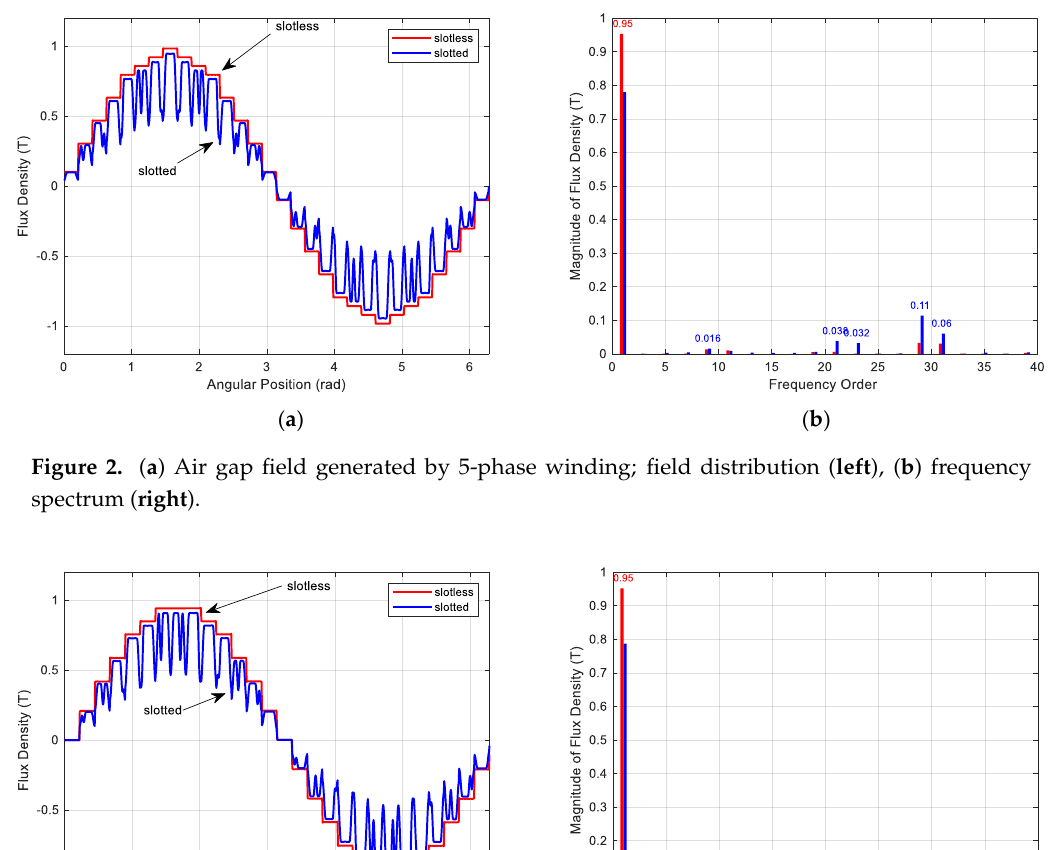
Figure 3 . ( a ) Air gap field generated by 7-phase winding; field distribution ( left ), ( b ) frequency spectrum ( right ). First, the spectrum includes all harmonics orders calculated from (19). When the operator “ + ” is used, the relevant harmonic generates mmf travelling the air gap together with the fundamental harmonic but 𝜈 -times slower, and to the contrary, the operator “ − ” gives harmonics producing waves traveling the air gap in opposite direction (also 𝜈 -times slower). 𝜈 = 2𝑚𝑐 ± 1, 𝑐 ∈ ℤ